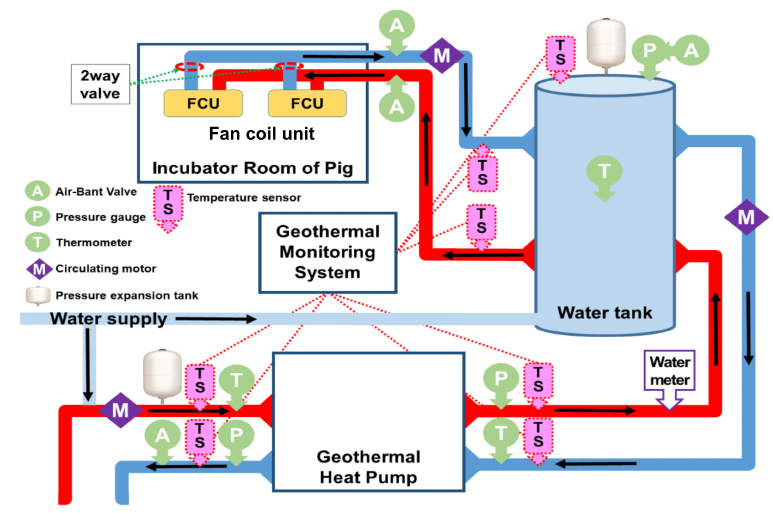
Figure 3. An overview of the ground source geothermal heat pump